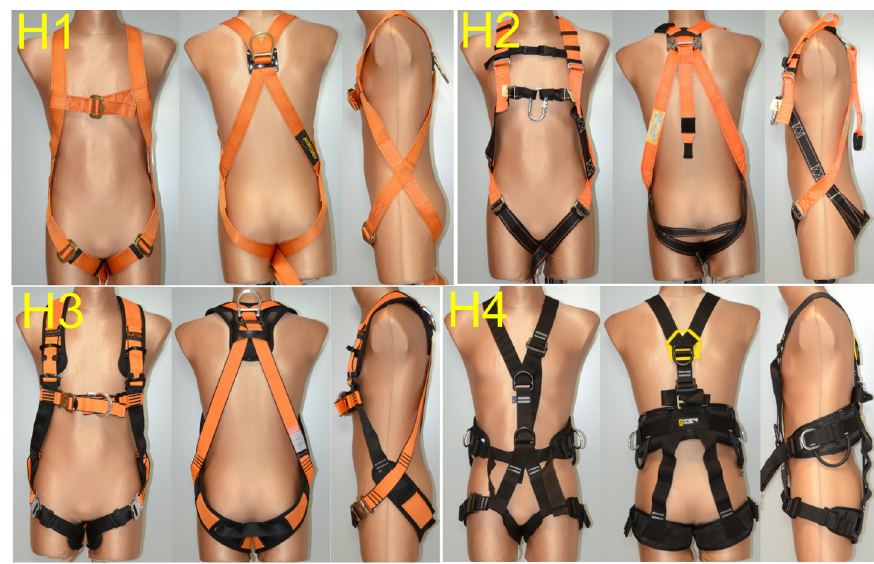
Figure 1. Safety harnesses tested in terms of their effects on the user’s body in suspension. Table 1. Safety harnesses used in the tests.